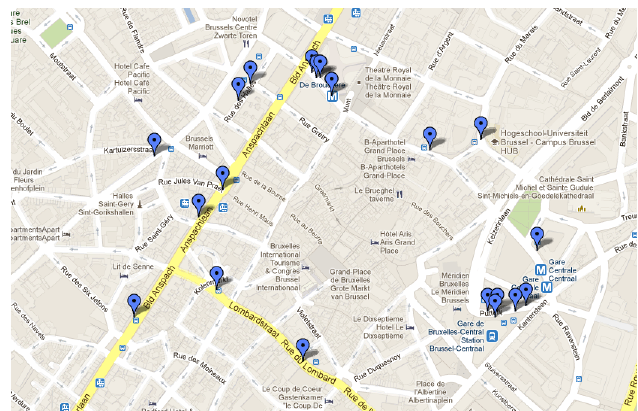
Figure 7. Stops closest to Grand Place.